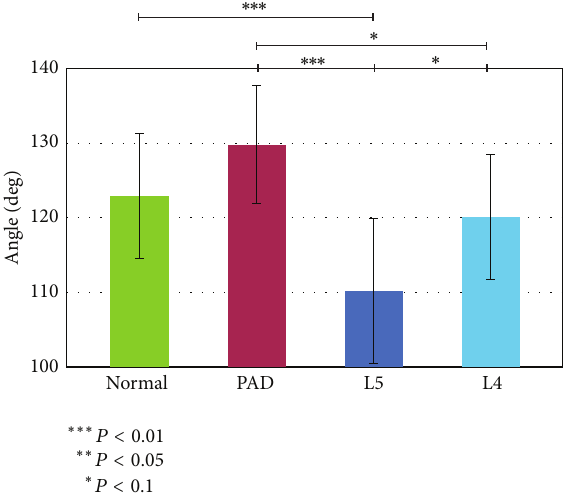
Figure 4: Mean ankle